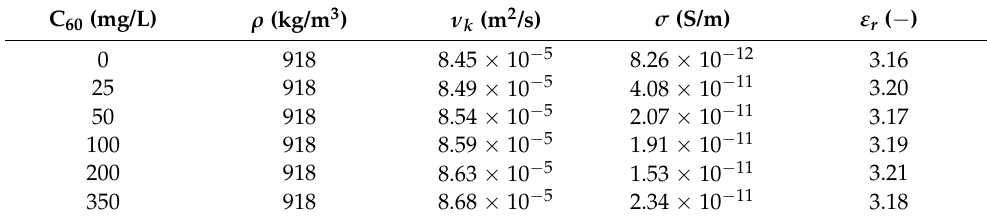
Table 3. Properties of C 60 fullerene doped Midel 1204 natural ester (20 ◦ C).